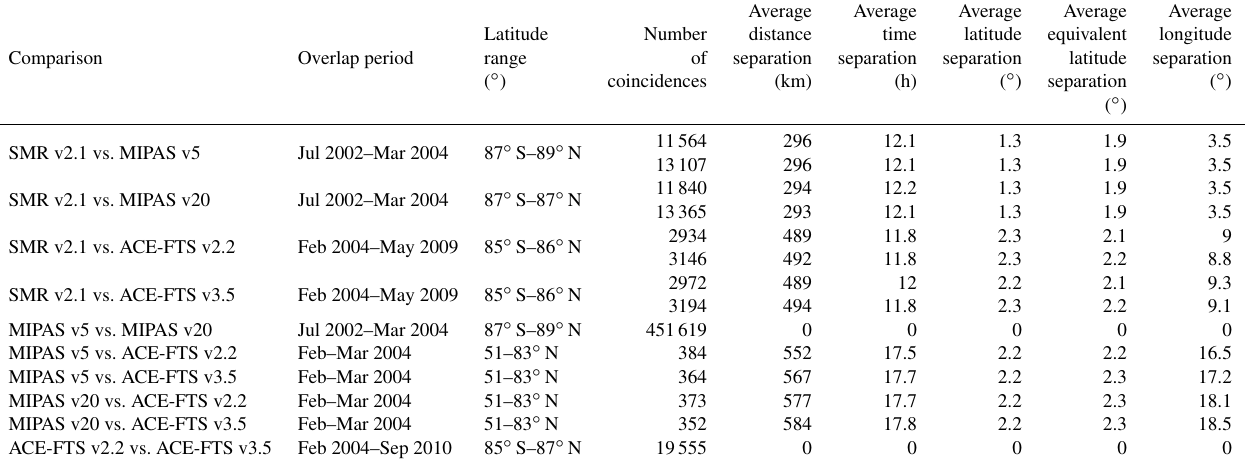
Table 2. Overview of the profile-to-profile comparisons and their coincidence characteristics. For comparisons to the SMR data set the characteristics vary slightly depending upon if the comparison considers HDO (upper row) or H 2 O (lower row). The determination of the overlap period and latitude range uses the data from both data